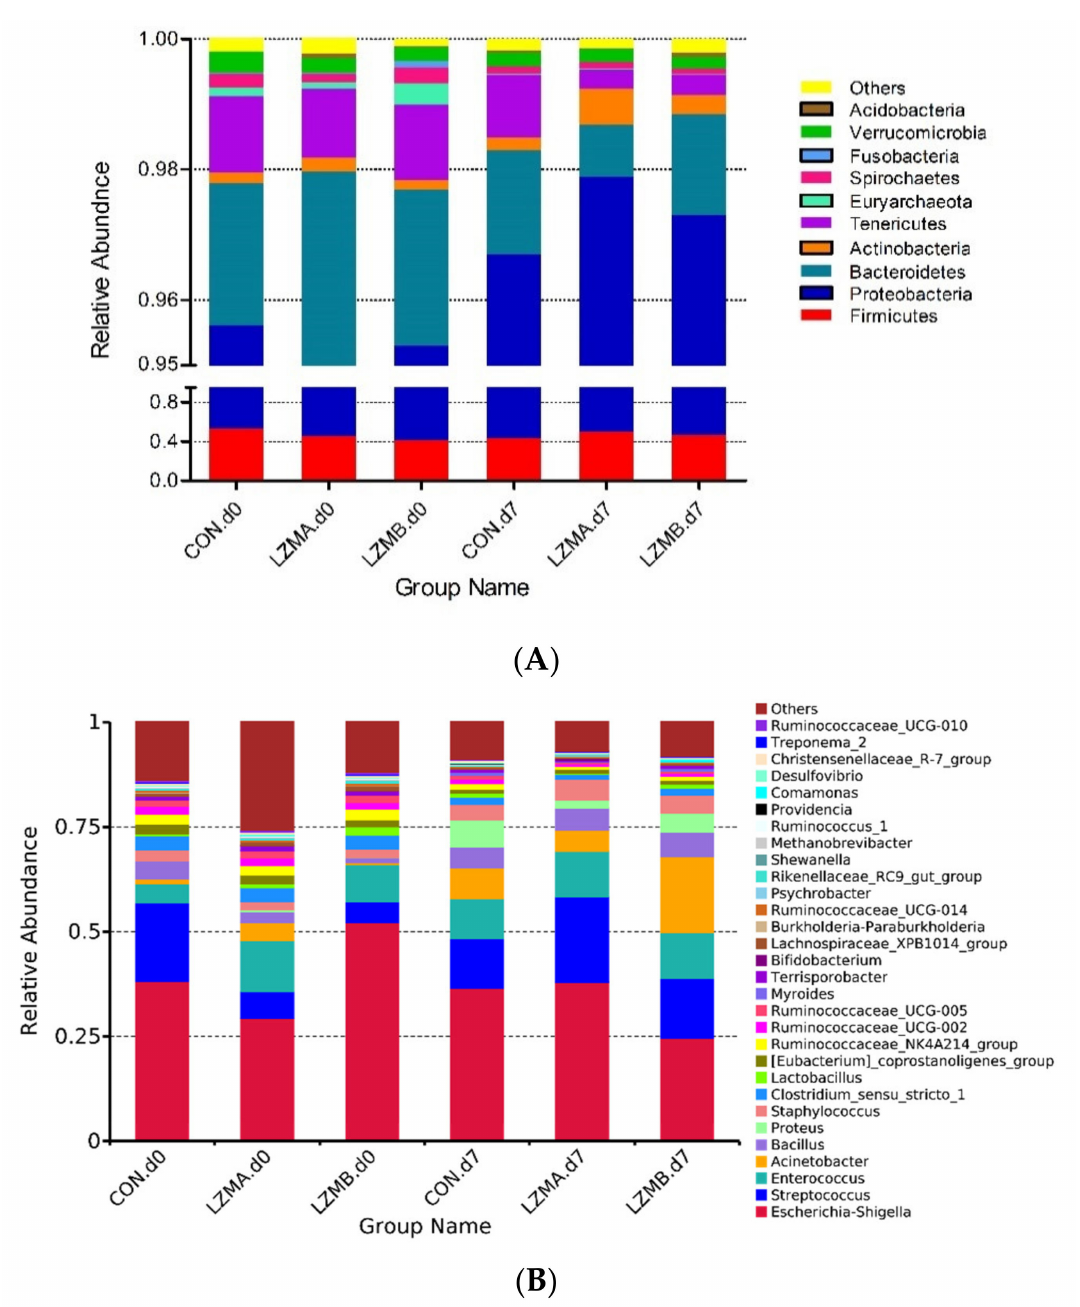
Figure 3. 16S rRNA gene analysis reveals phyla ( A ) and genus ( B ) level differences in sow vagina between the treatments. CON. d0 = control diet at the day of farrowing, CON. d7 = control diet at day 7 of lactation, LZMA d0 = control diet + lysozyme 150 mg/kg at the day of farrowing, LZMA d7 = control diet + lysozyme 150 mg/kg at day 7 of lactation, LZMB d0 = control diet + lysozyme 300 mg/kg at the day of farrowing, LZMB d7 = control diet + lysozyme 300 mg/kg at day 7 of